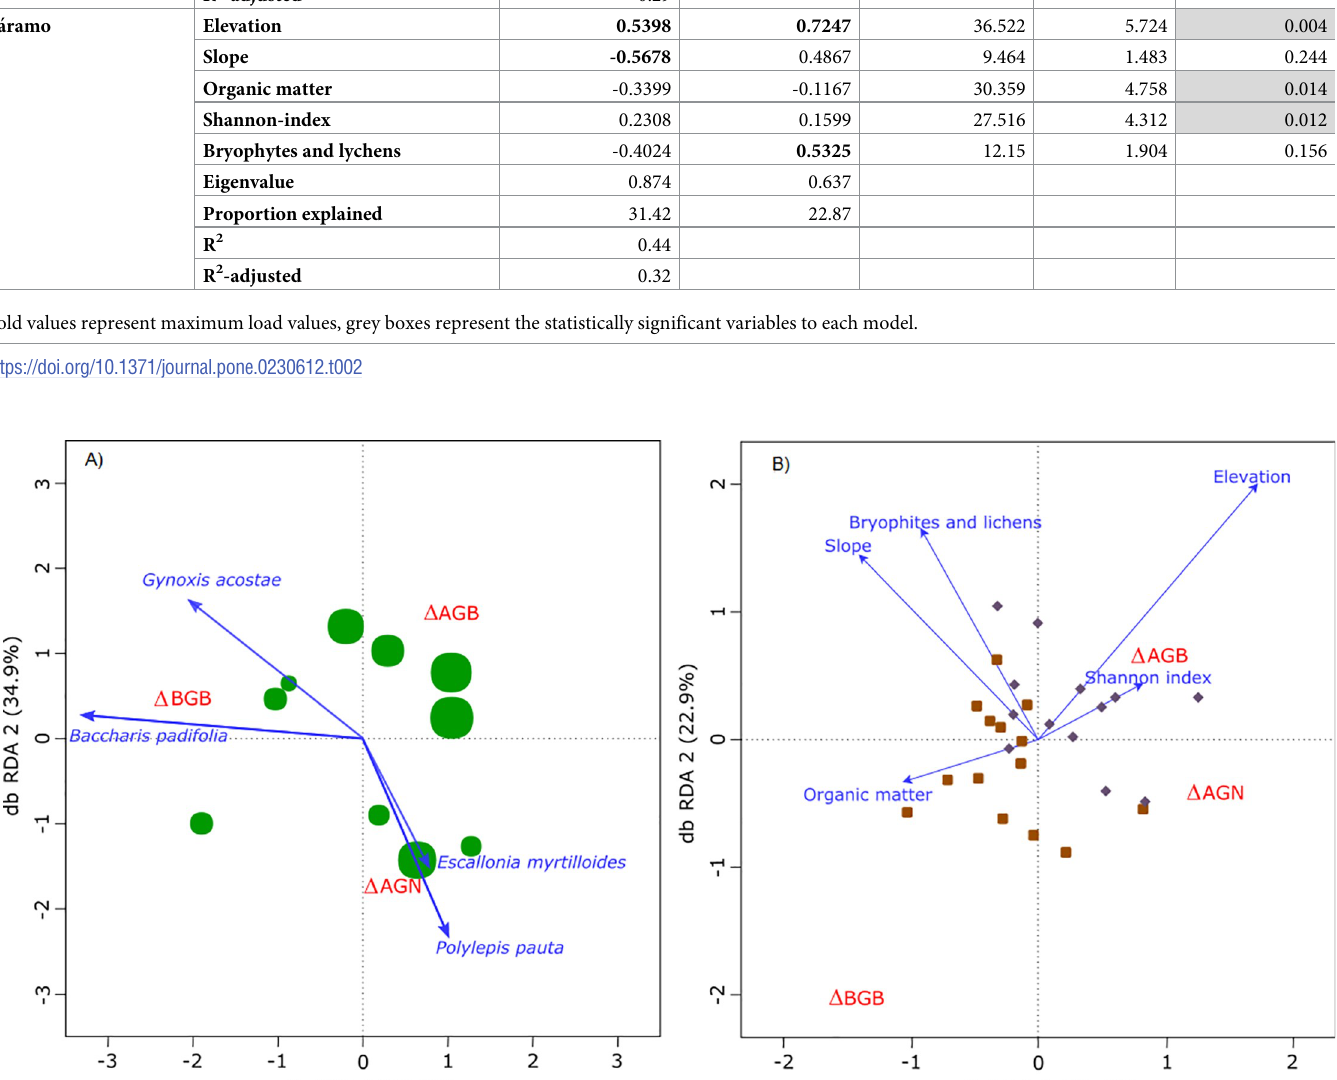
PLOS ONE | https://doi.org/10.1371/journal.pone.0230612 March 30,